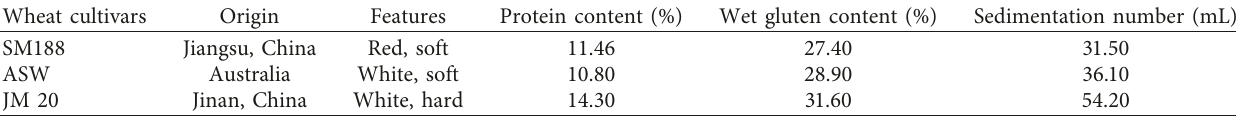
Table 1: Origin and quality characteristics of wheat used for flour samples